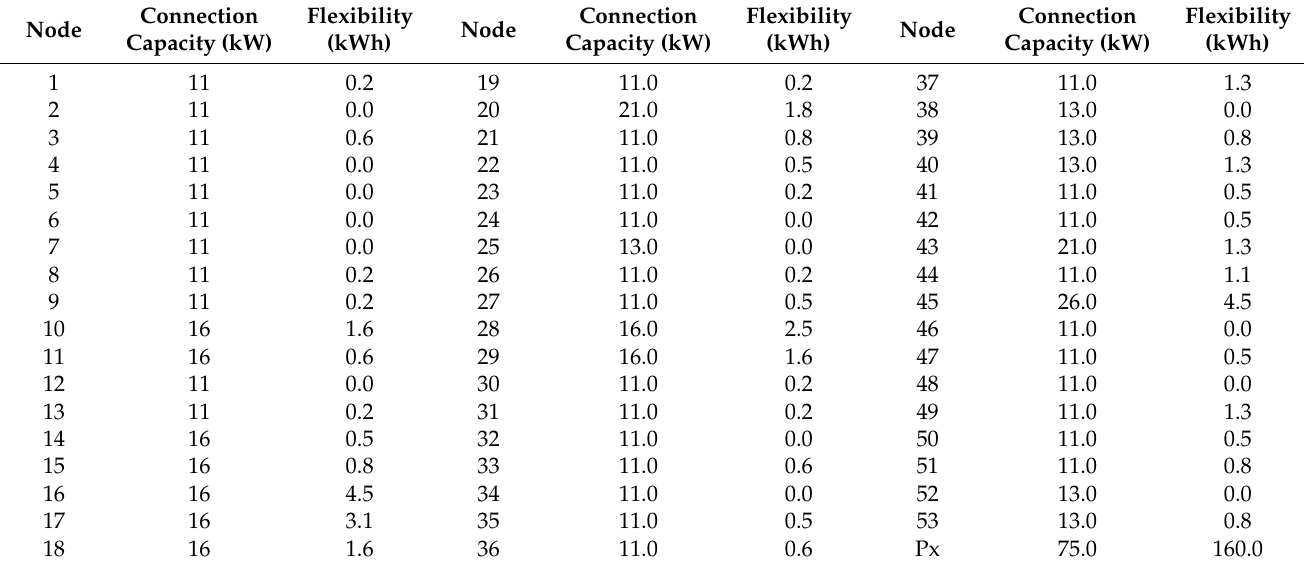
Table 2. A general summary of control and state variables for LEC nodes used in the case